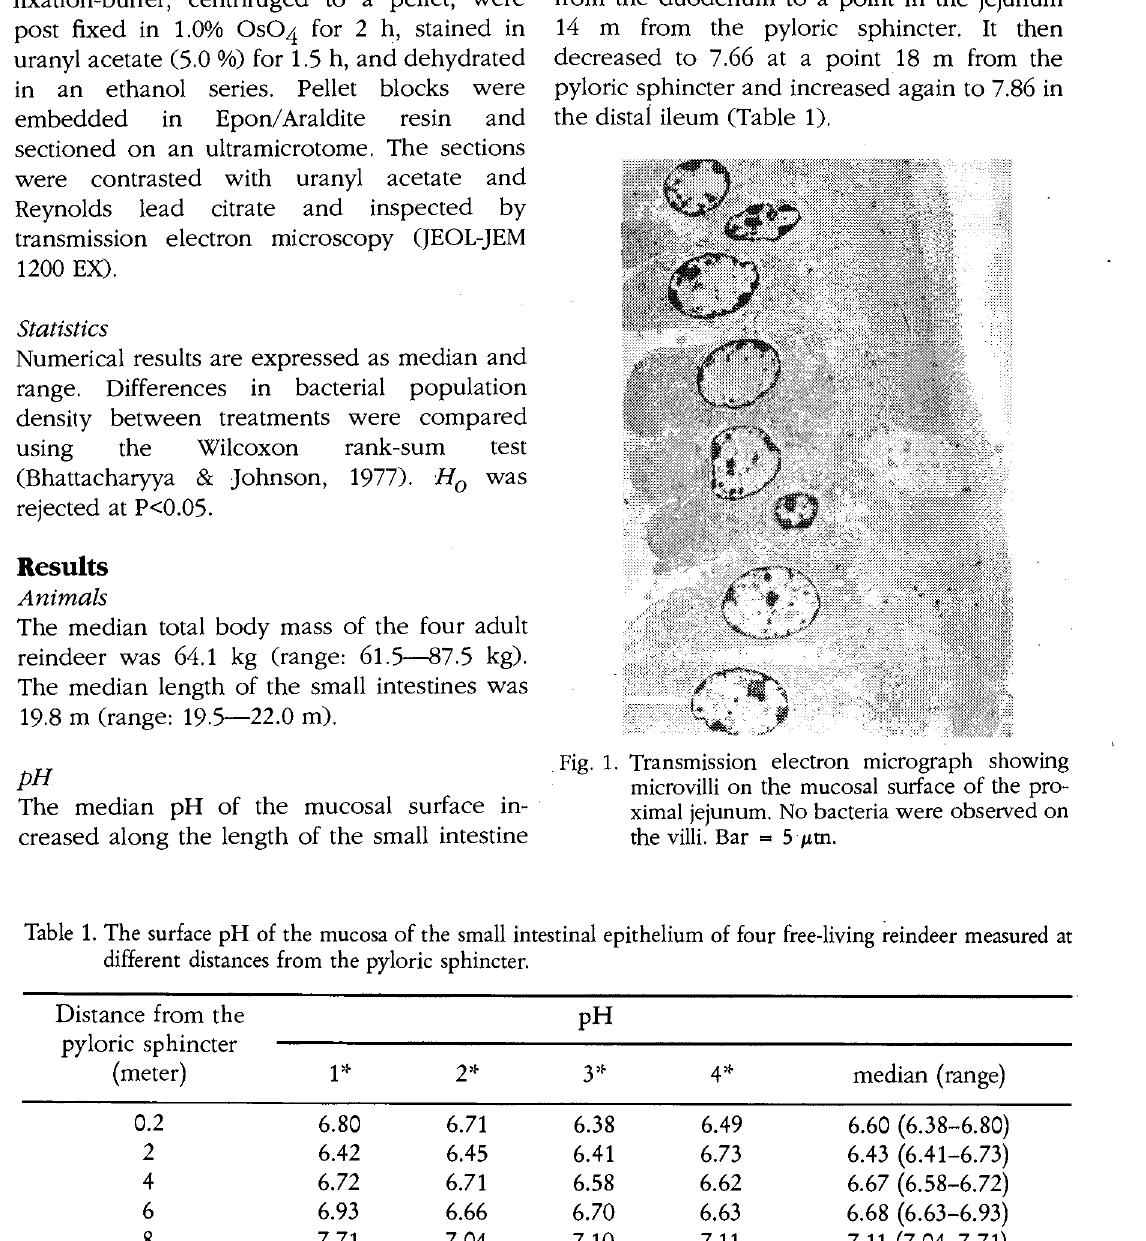
Table 1. The surface pH of the mucosa of the small intestinal epithelium of four free-living reindeer measured at different distances from the pyloric